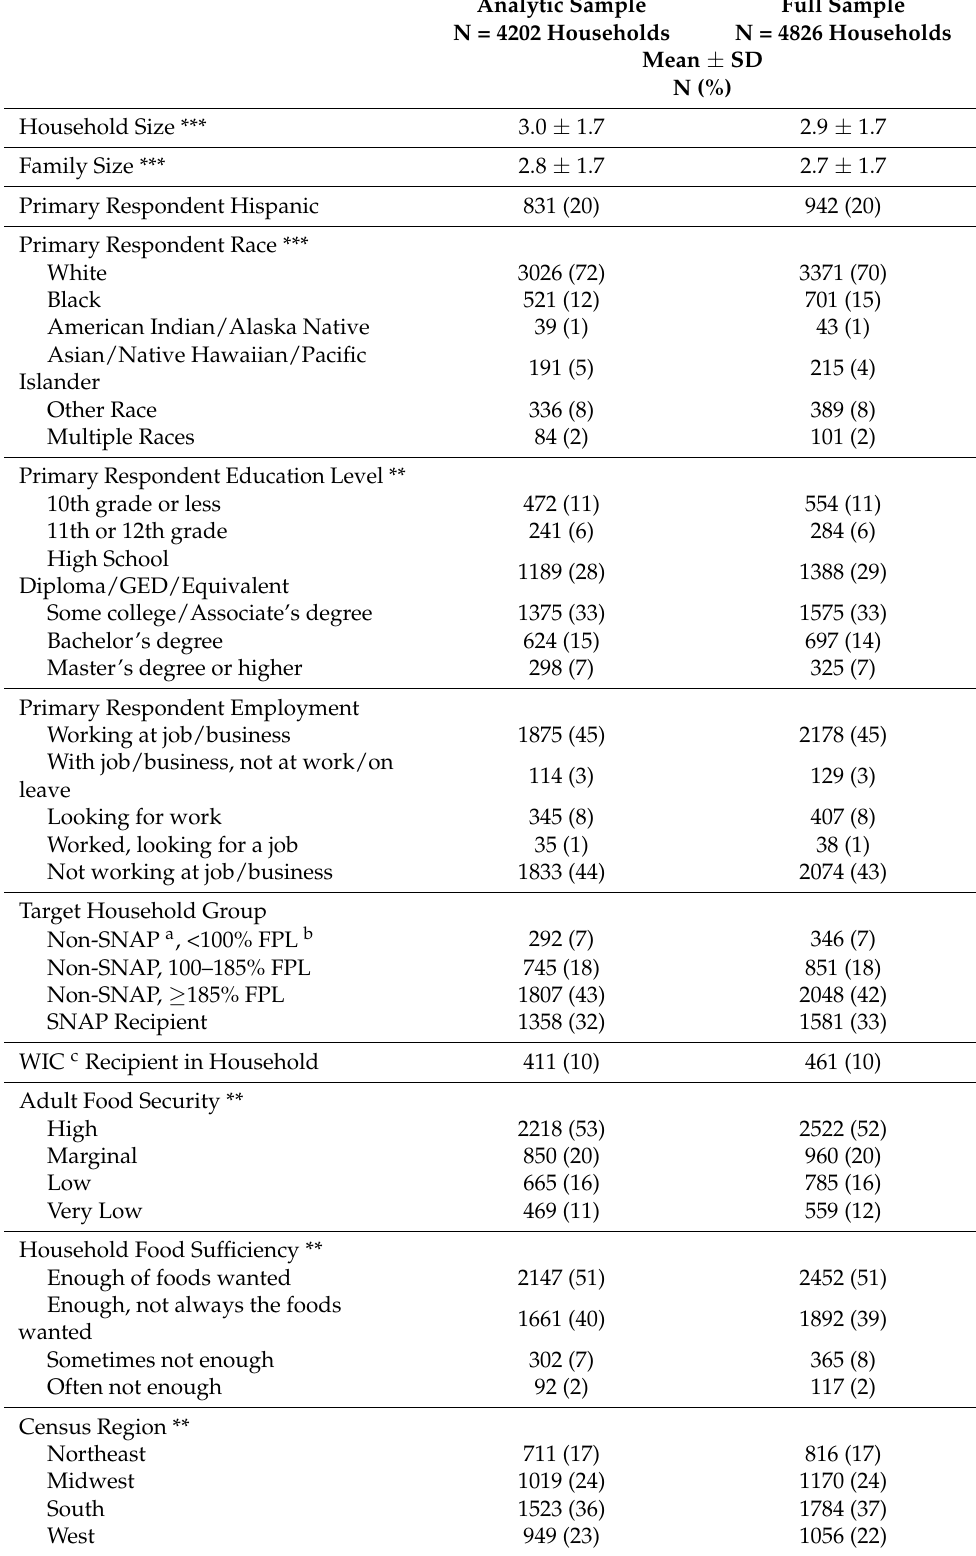
Table 2. Household